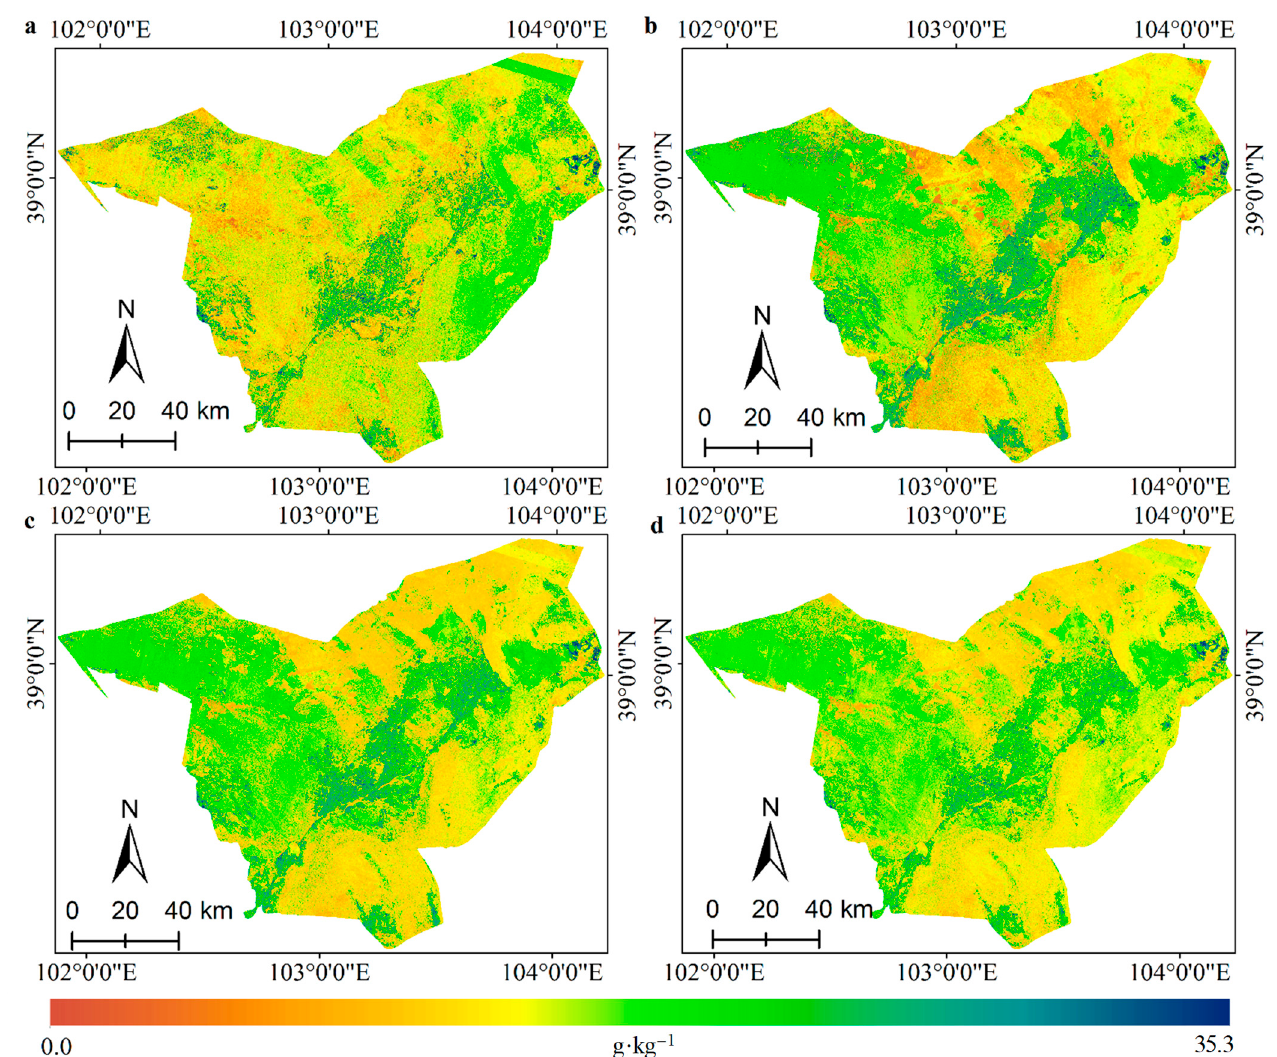
Figure 5. Averaged SOM maps from 20-fold cross-validation machine learning models, i.e., ( a ) RR, ( b ) LS-SVM, ( c ) RF, and ( d ) GBRT, using the XWT-based framework. All images are displayed within an identical range (0–35.3 g·kg − 1 ).